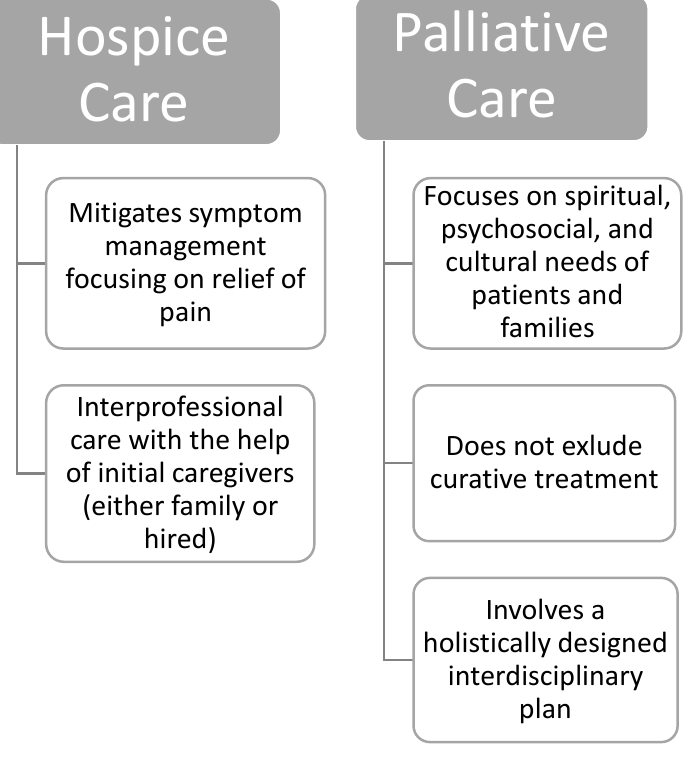
Figure 1: Main differences between Hospice and Palliative